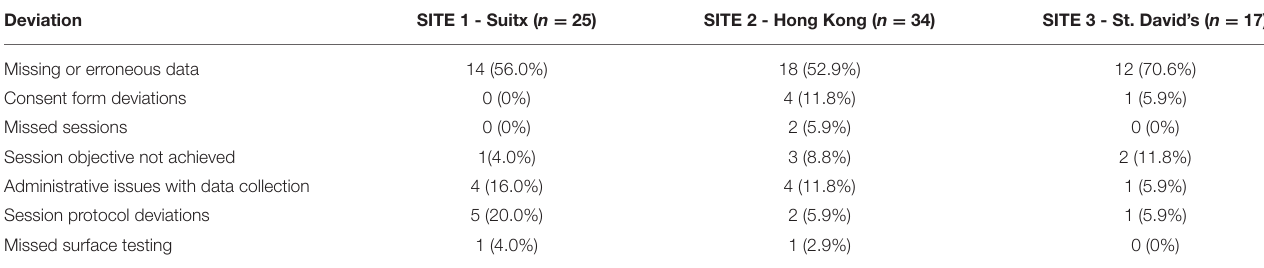
TABLE 10 | Protocol deviation